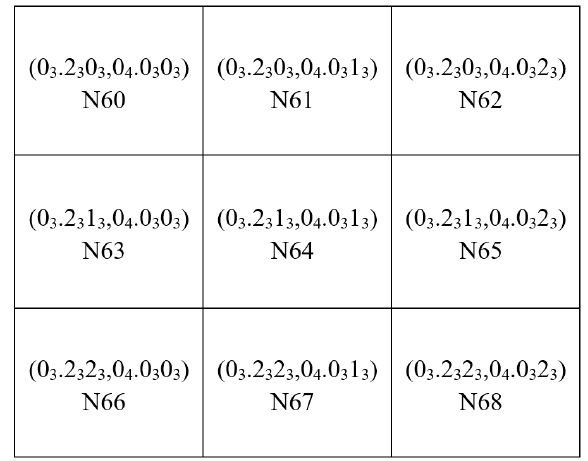
Figure 1. Planar and ellipsoidal grids (based on the (0, 0)-rHEALPix projection) of the rHEALPix DGGS with N side = 3 at ( a ) resolution i = 0 and ( b ) resolution i = 1. (Source: [23])